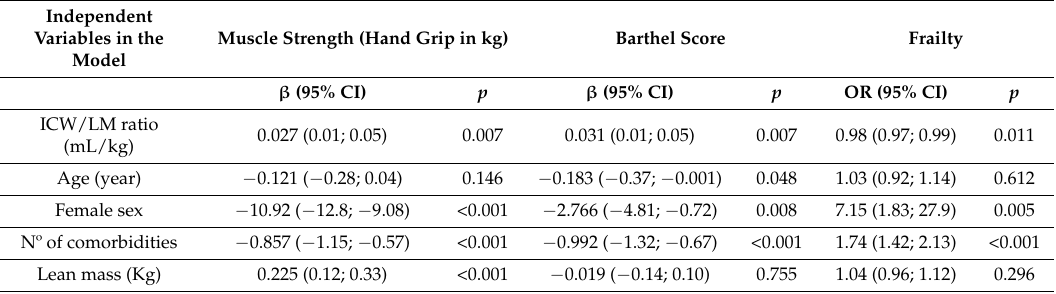
Table 4. Multivariate analysis results for the independent effect of ICW/LM ratio (in mL/kg) on muscle strength, functional capacity and